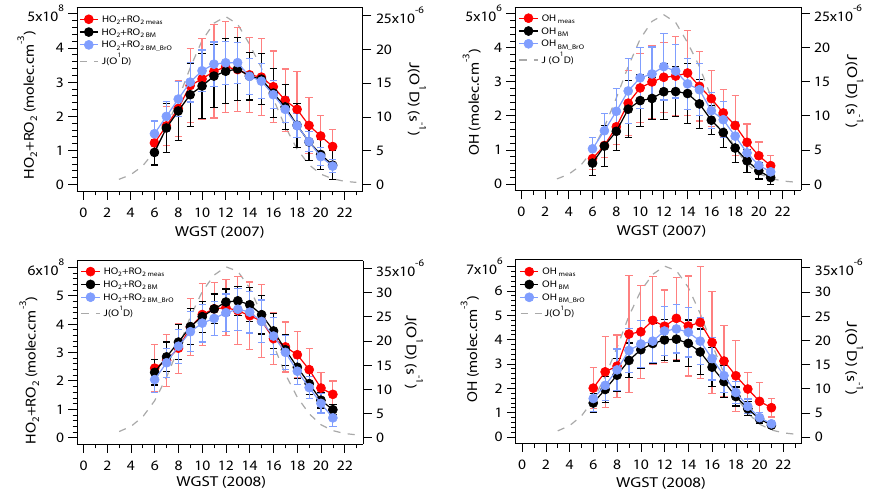
Fig. 7. The average diurnal profiles of hourly OH and HO 2 +RO 2 observations (red dots and line) and predictions from the BM (black dots and line) and BM BrO CIMS (blue dots and line), and diurnal profile of J (O 1 D) (gray dash line) in spring 2007 and summer 2008. The error bars (red) of the observations are the overall uncertainties including the measurement uncertainties and ambient fluctuations. The error bars (gray and blue) of the predictions are the propagated uncertainties from the model input uncertainties and variations.